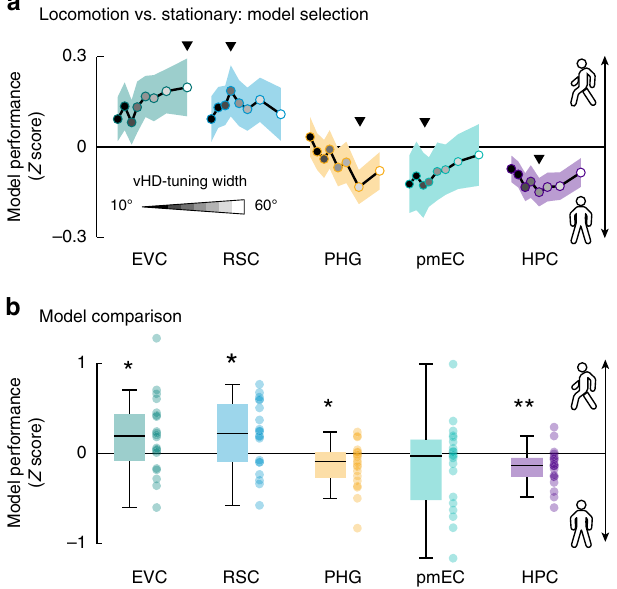
Fig. 6 Behavioral-state analysis. The analysis described in Fig. 2 was repeated, this time separating periods when participants navigated and when they stood still. a Model selection. We plot the difference in model performance ( Z score) between locomotion and stationary periods across tuning widths (grayscale dots represent tuning width: narrow:dark, wide: light, also see Fig. 5). Positive values indicate that voxel time courses in an ROI could be better predicted when participants locomoted. Negative values indicate the opposite, with better model performance during stationary periods. Triangles mark the kernel width, leading to the strongest difference between models. b Model comparison. We plot the difference in model performance indicated in ( a ) as single-participant data and group- level whisker – boxplots (center, median; box, 25th to 75th percentiles; whiskers, 1.5× interquartile range, n = 20 participants). EVC and RSC tended to be better predicted during locomotion; PHG and HPC could be better predicted during stationary periods. These results suggest that the tuning in visual and mnemonic regions depends on the locomotory state. Two-sided permutation-based t -test results were added: ** P < 0.05, FDR- corrected, * P < 0.05, uncorrected. Source data are provided as a Source Data fi